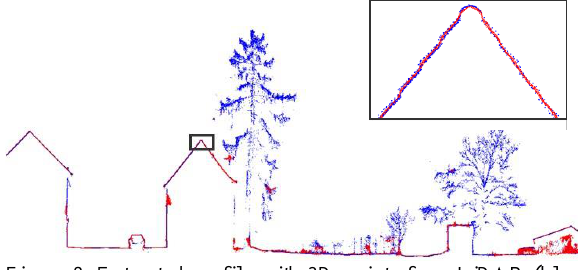
Figure 8. Extracted profile with 3D points from LiDAR (blue) and MVS